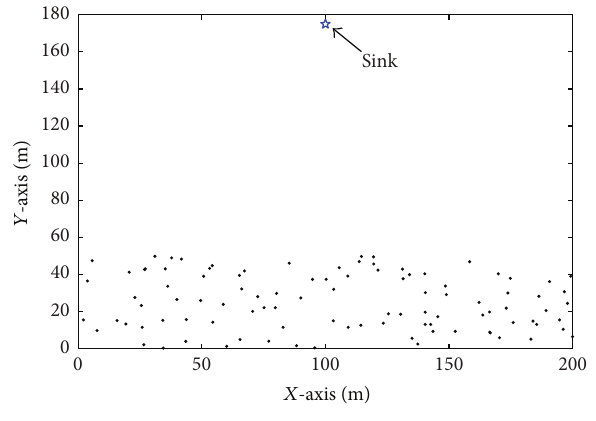
Figure 4: 100-node random network. Table 1: The parameters of the network in simulations.